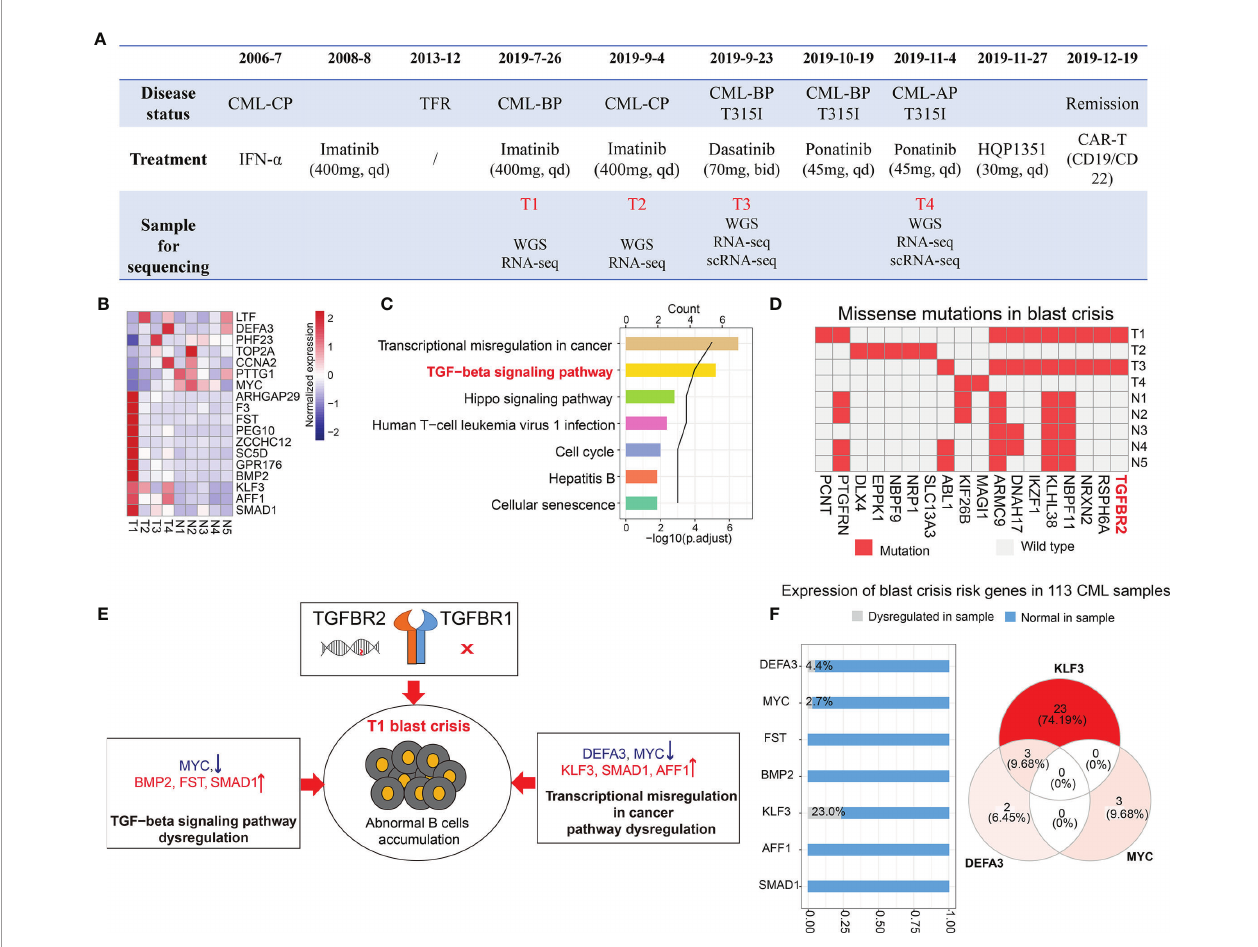
FIGURE 2 | Transcriptomic and genomic analysis of the blast crisis sample. (A) The timeline of disease progression, treatment, and sample collection. (B, C) Shared differential genes in the comparisons of T1 vs . T3 and T1 vs . NCBI samples (B) and their enriched pathways (C) . (D) Missense mutations in our samples (T1 – T4) and published blast crisis samples (N1 – N5). (E) The possible mechanisms leading to the sudden blast crisis at T1. (F) The bar plot shows the proportion of chronic myeloid leukemia (CML) samples with or without the dysregulation of CML blast crisis risk genes. The Venn diagram shows the distribution of three dysregulated blast crisis risk genes (KLF3, DEFA3, and MYC) in the